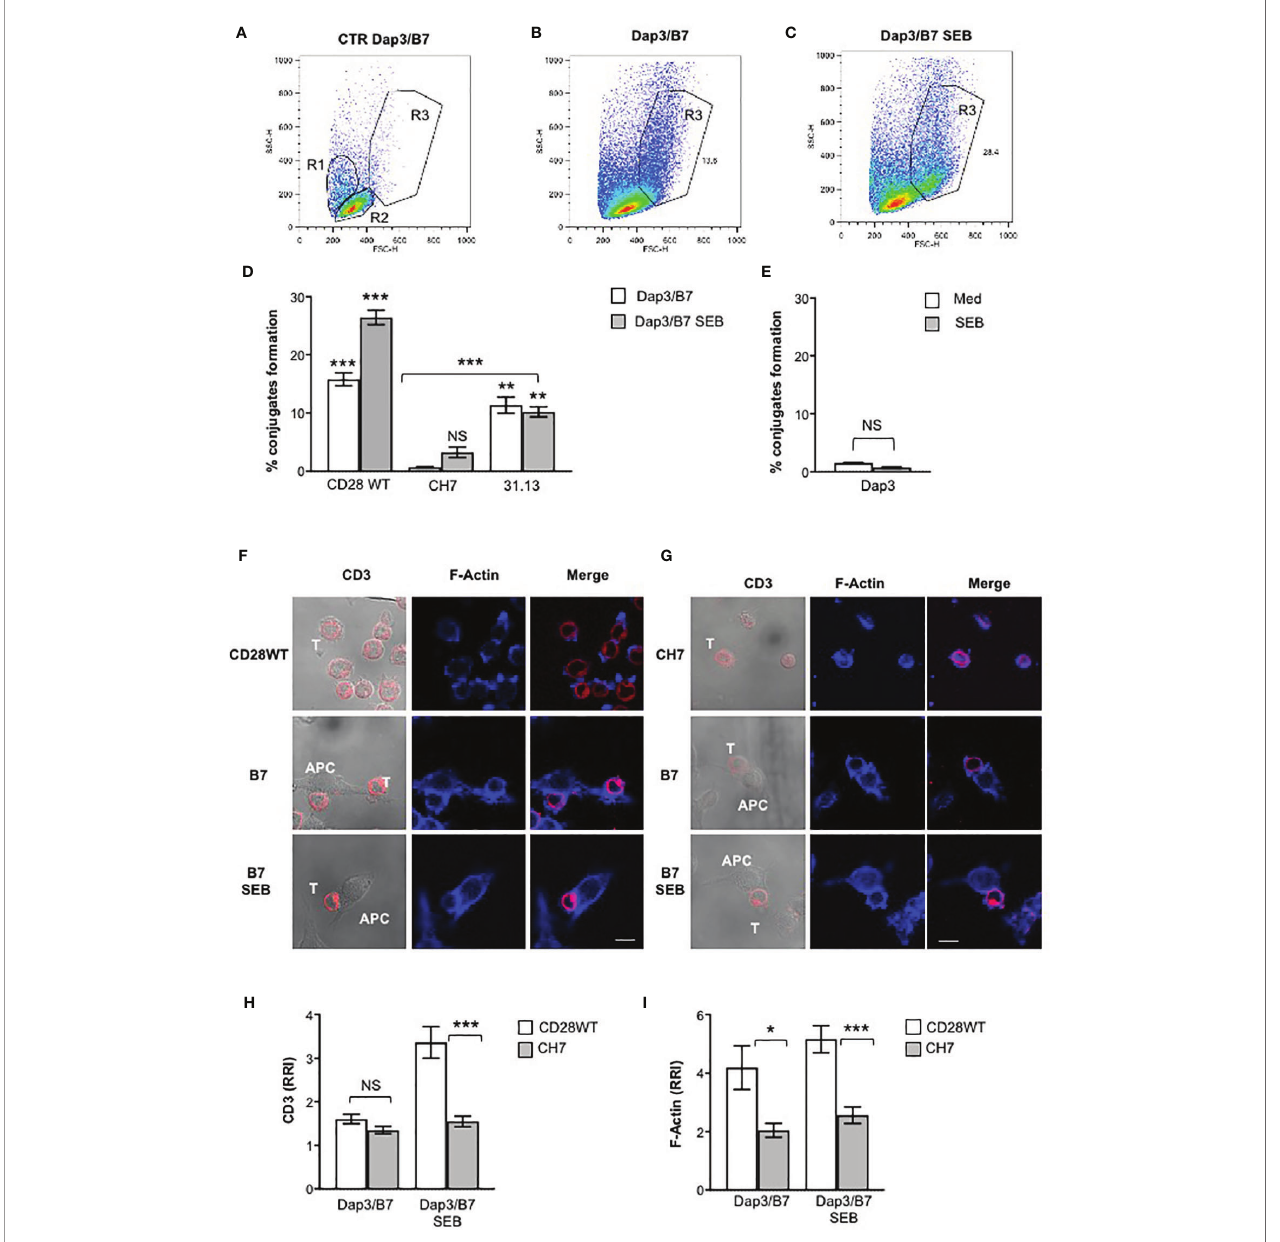
FIGURE 7 | SEB increases T:APC conjugate formation and induces TCR recruitment into the immunological synapse. (A, E) CD28WT, CH7, and 31.13 cells were stimulated for 20 minutes with Dap3/B7 cells in the presence or absence of SEB and conjugate formation was analysed by FACS. (A – C) SSC vs FSC dot plots of CD28WT and Dap3/B7 cells either unconjugated (A) or conjugated for 20 minutes in the absence (B) or presence of SEB (C) . R1 and R2 gates (A) indicate the position of Dap3/B7 and CD28WT cells, respectively. Conjugates (B, C) were identi fi ed within the R3 gate and expressed as the mean percentage ± SEM of three independent experiments. (D, E) Conjugates formation between CD28WT, CH7, 31.13 cells (D) and Dap3 cells in the absence (Med) or presence of SEB expressed as the mean percentage ± SEM of three independent experiments. Statistical signi fi cance was calculated by Student ’ s t test. Mean percentage values: CD28WT, Dap3 = 1.5, Dap3 SEB = 0.8, Dap3/B7 = 15.8, Dap3/B7 SEB = 26,43; CH7, Dap3/B7 = 0.6, Dap3/B7 SEB = 3.2; 31.13, Dap3/B7 = 11.3, Dap3/B7 SEB= 10.1%. (F – I) CD28WT cells (F) or CH7 cells (G) were unstimulated or incubated with adherent Dap3/B7 (B7) in the presence or absence of SEB for 20 minutes. After fi xing and permeabilization, CD3 (red) and F-actin (blue) were stained with anti-CD3 Ab (UCHT1) followed by Alexa 594-coniugated goat anti-mouse Ab and 633- conjugated phalloidin, respectively. The results (F, G) are representative of three independent experiments. The scale bar represents 10 µM. The relative recruitment index (RRI) of CD3 (H) and F-Actin (I) was calculated. Data represent the mean ± SEM of thirty-one conjugates analysed in each group. Statistical signi fi cance was calculated by Student ’ s t test. Mean values: CD3 CD28WT B7 = 1.6, CH7 B7 = 2.1, CD28WT B7 SEB = 3.4, CH7 B7 SEB = 1.7; F-Actin, CD28WT B7 = 4, CH7 B7 = 2, CD28WT B7 SEB = 5, CH7 B7 SEB = 2.5. (*) p< 0.05, (***) p < 0.001, (****) p < 0.0001. NS, not signi fi